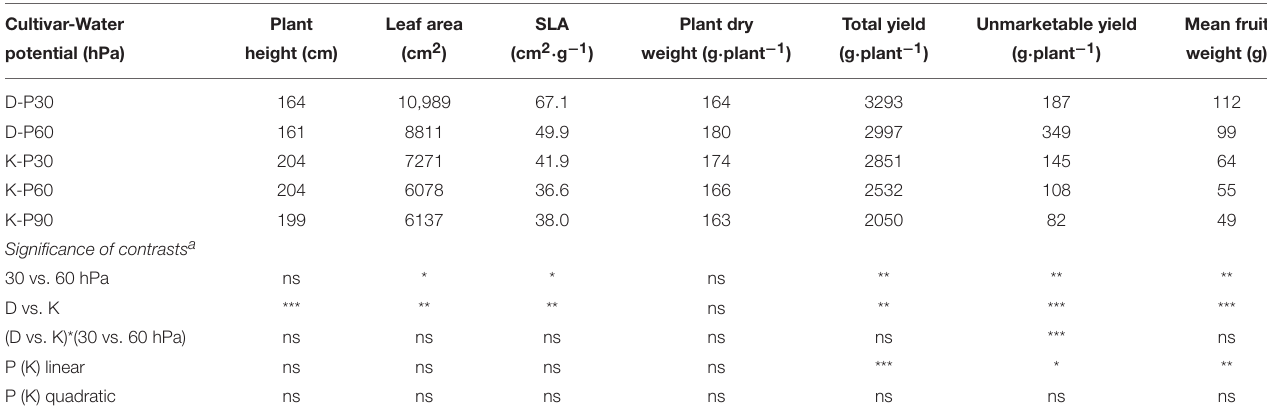
TABLE 2 | Effect of cultivar (Diana—D and Kabiria—K) and growing-media matric potential (P) on plant height, leaf area, specific leaf area (SLA), total dry weight, total and unmarketable yield, and mean fruit weight of subirrigated soilless tomato under controlled water stress conditions.